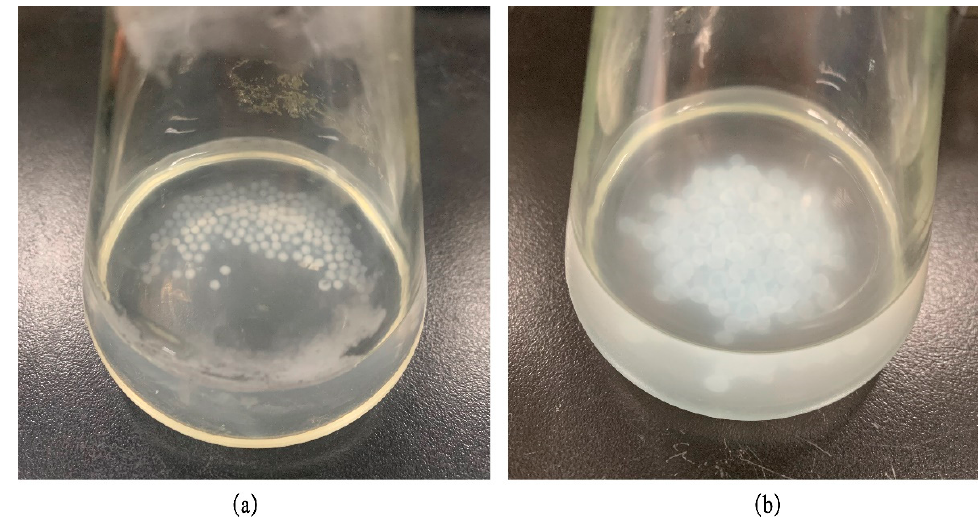
Figure 5. Fitting results of first-order release model of BEO microcapsules in SGF and SIF.